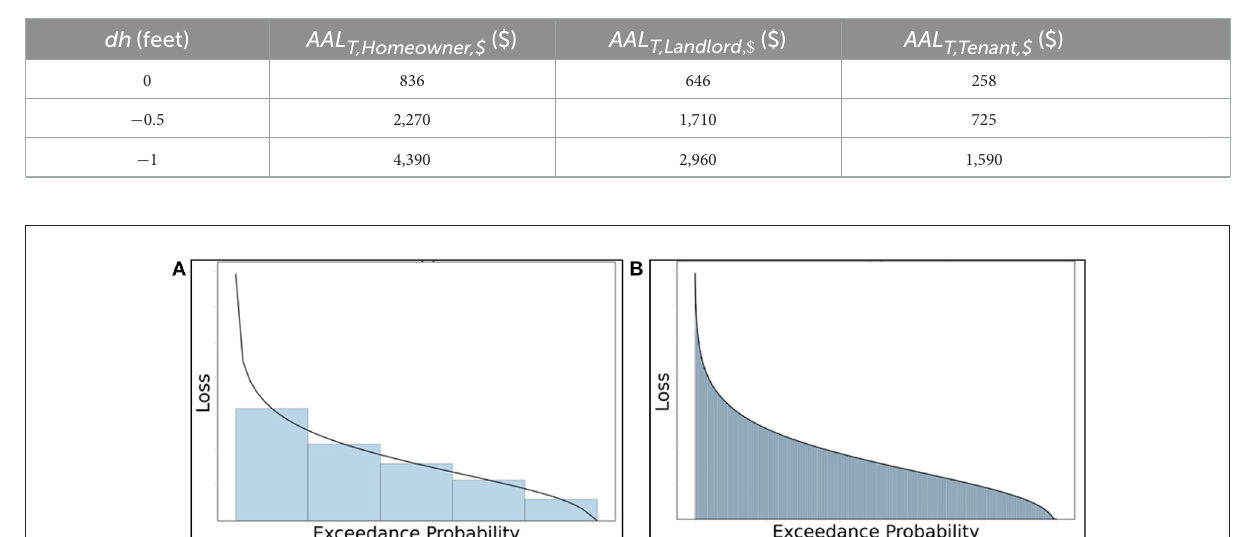
TABLE 6 Sensitivity of the average annual loss mean values (USD) per home for homeowner, landlord, and tenant to depth-damage function damage initiation point.